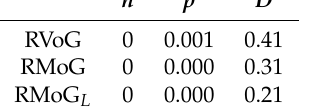
Table 7. Parameters of the two-dimensional KS test between biomass predicted by Lidar and PolInSAR. h